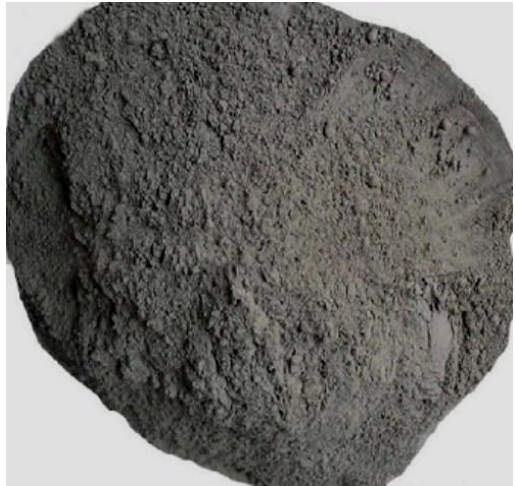
Figure 1. CEM I 42.5 R cement appearance.